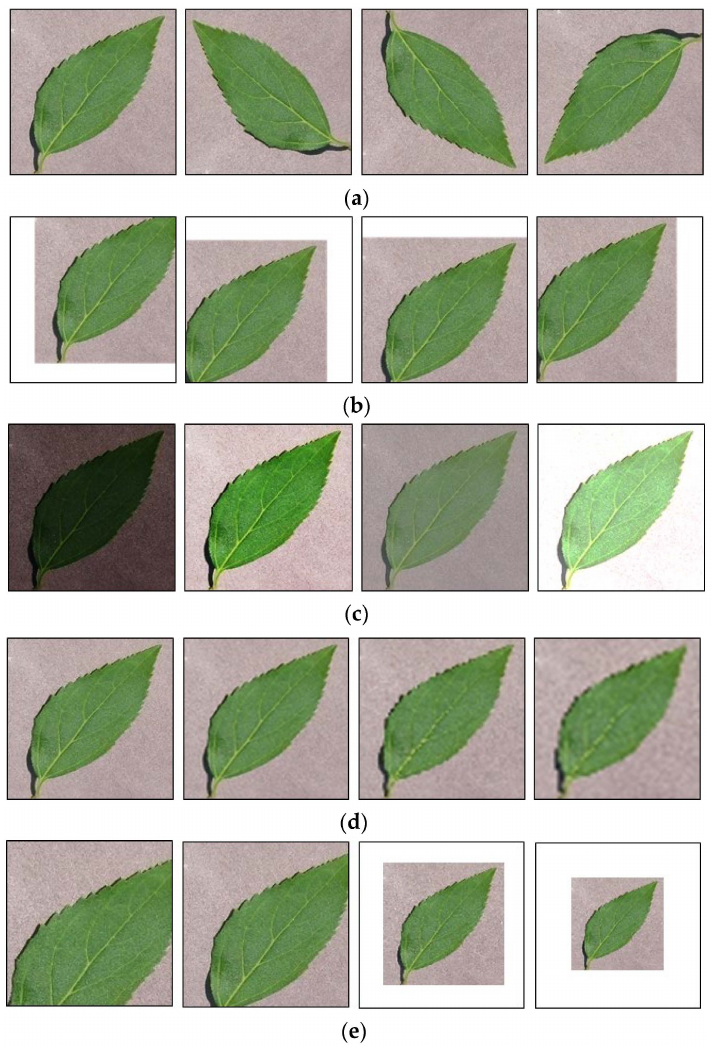
Figure 9. Examples of images augmented by conventional augmentation methods. Images aug- mented by ( a ) flipping and in-plane rotation; ( b ) image shifting in four directions; ( c ) the adjustments of brightness and contrast; ( d ) Gaussian blurring; ( e )